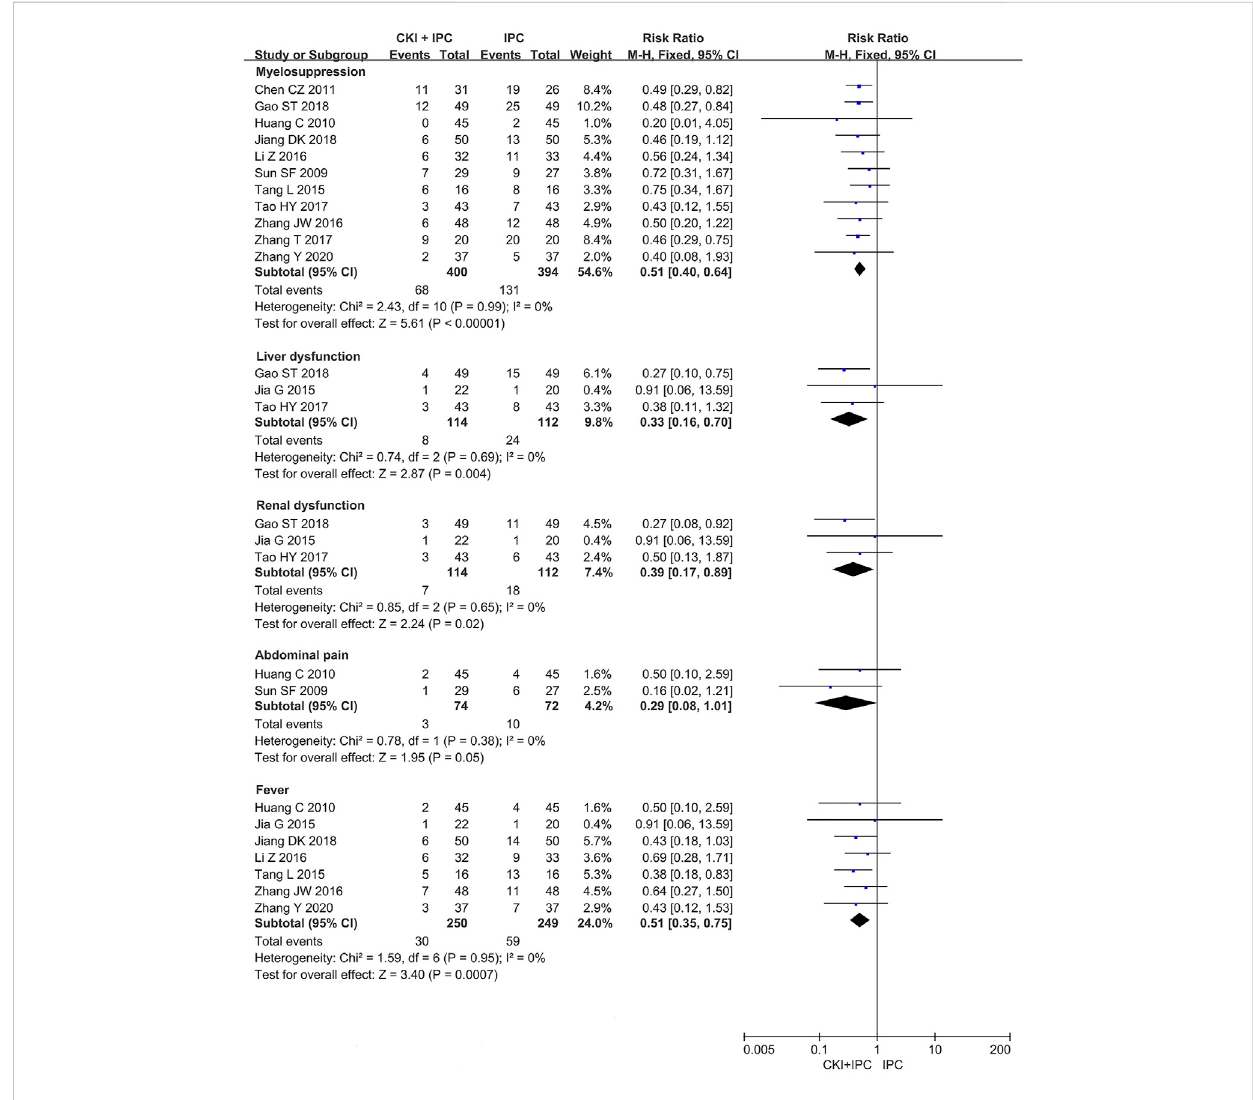
FIGURE 7 Forest plot and pooled risk ratios for the association of ADRs with CKI + IPC and